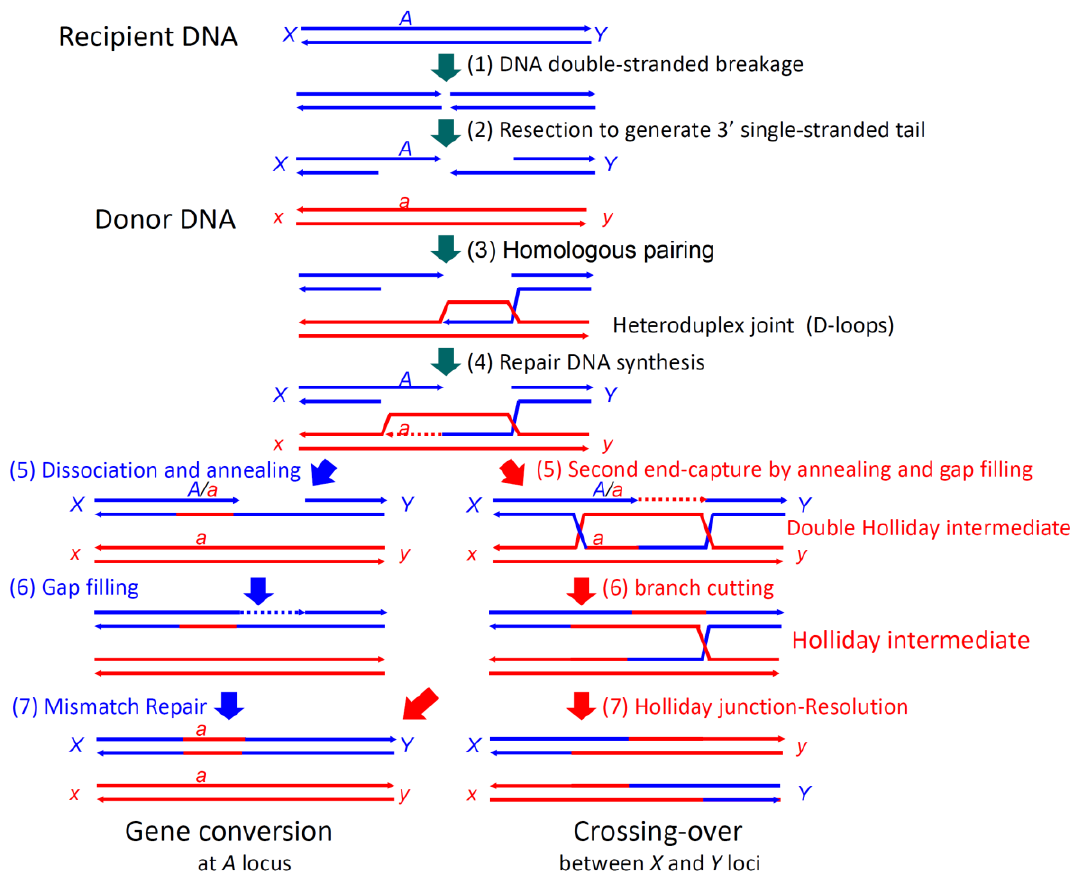
Figure 1. Pathways of homologous recombination. Both sides of a double-stranded break (Step 1) are resected to generate 3' single-stranded tails at Step 2. At Step 3, the single-stranded tail derived from the first end finds a complementary sequence within the homologous DNA and forms a heteroduplex with a D-loop (homologous pairing), followed by repair synthesis to restore the broken sequence from the paired 3' single-stranded tail at Step 4. DNA synthesis replaces the parental DNA strand to enlarge the D-loop. After Step 5, the double-stranded break-repair pathway is illustrated on the right and the synthesis- dependent strand-annealing (SDSA) pathway is on the left. In the double-stranded break- repair pathway, the second end is captured by annealing with the D-loop at Step 5. The following gap filling and branch migration generate a double-Holliday intermediate. Cleavage of one of the inter-crossed strands leads to the Holliday intermediate at Step 6. At Step 7, the Holliday intermediate can be resolved in two ways, by cutting either the outer strands, to generate the crossing-over product, or the inter-crossed strands, to generate the gene conversion product after mismatch repair. In the SDSA pathway, the synthesized strand is dissociated from the double-stranded DNA and anneals with the second end at Step 5, followed by gap filling (Step 6) and mismatch repair (Step 7) to generate only a gene conversion product. A and a , X and x , and Y and y are alleles at the A , X and Y loci,